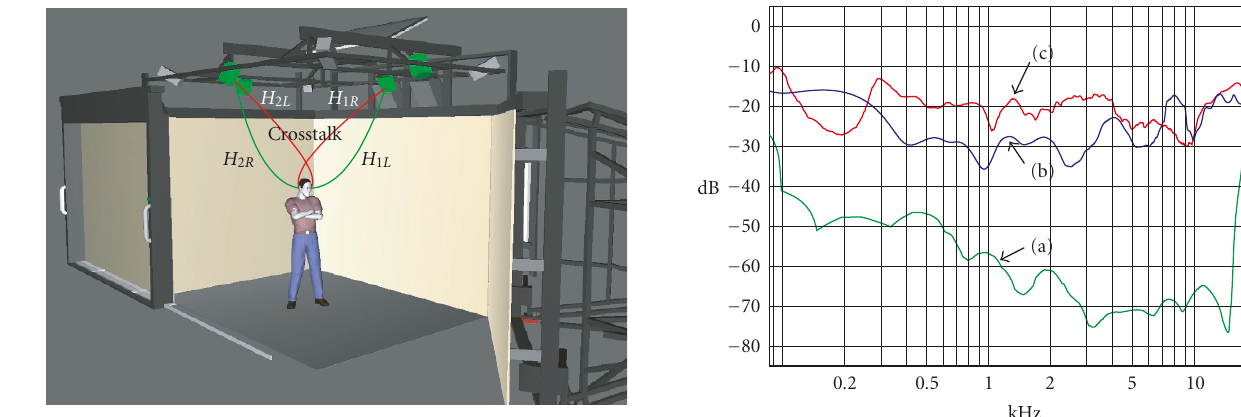
Figure 9: Measurement of the accessible channel separation using a filter length of 1024 taps. (a) = calculated, (b) = static solution, (c) = dynamic